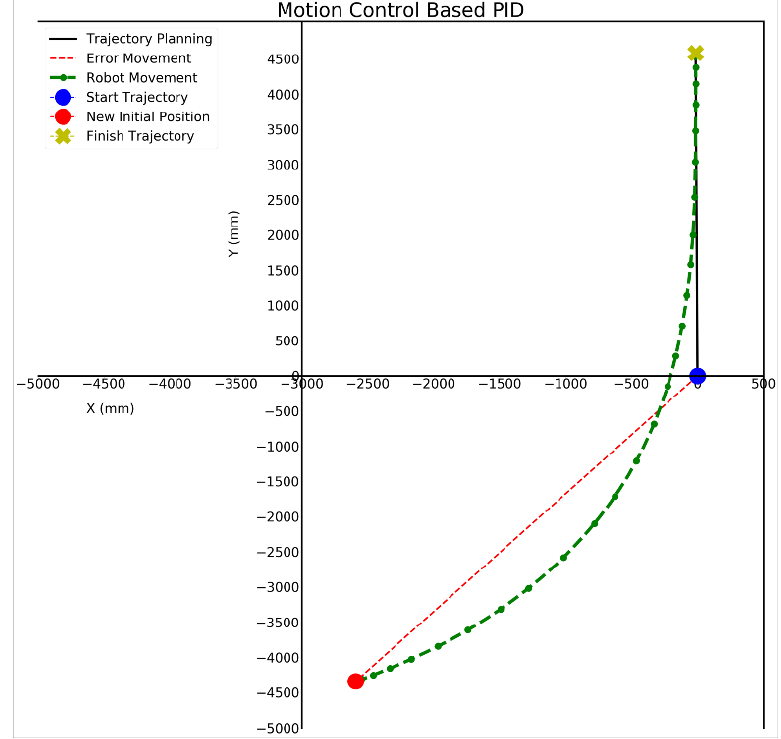
Figure 14. System Response of PID Motion Control in Coordinates of the Experimental Robot: Movement 2. The third test was performed with the robot placed at (4.5m, -4.5m). Based on the test result in Figure 15, the robot began to follow the trajectory at (0.0, 2.0)